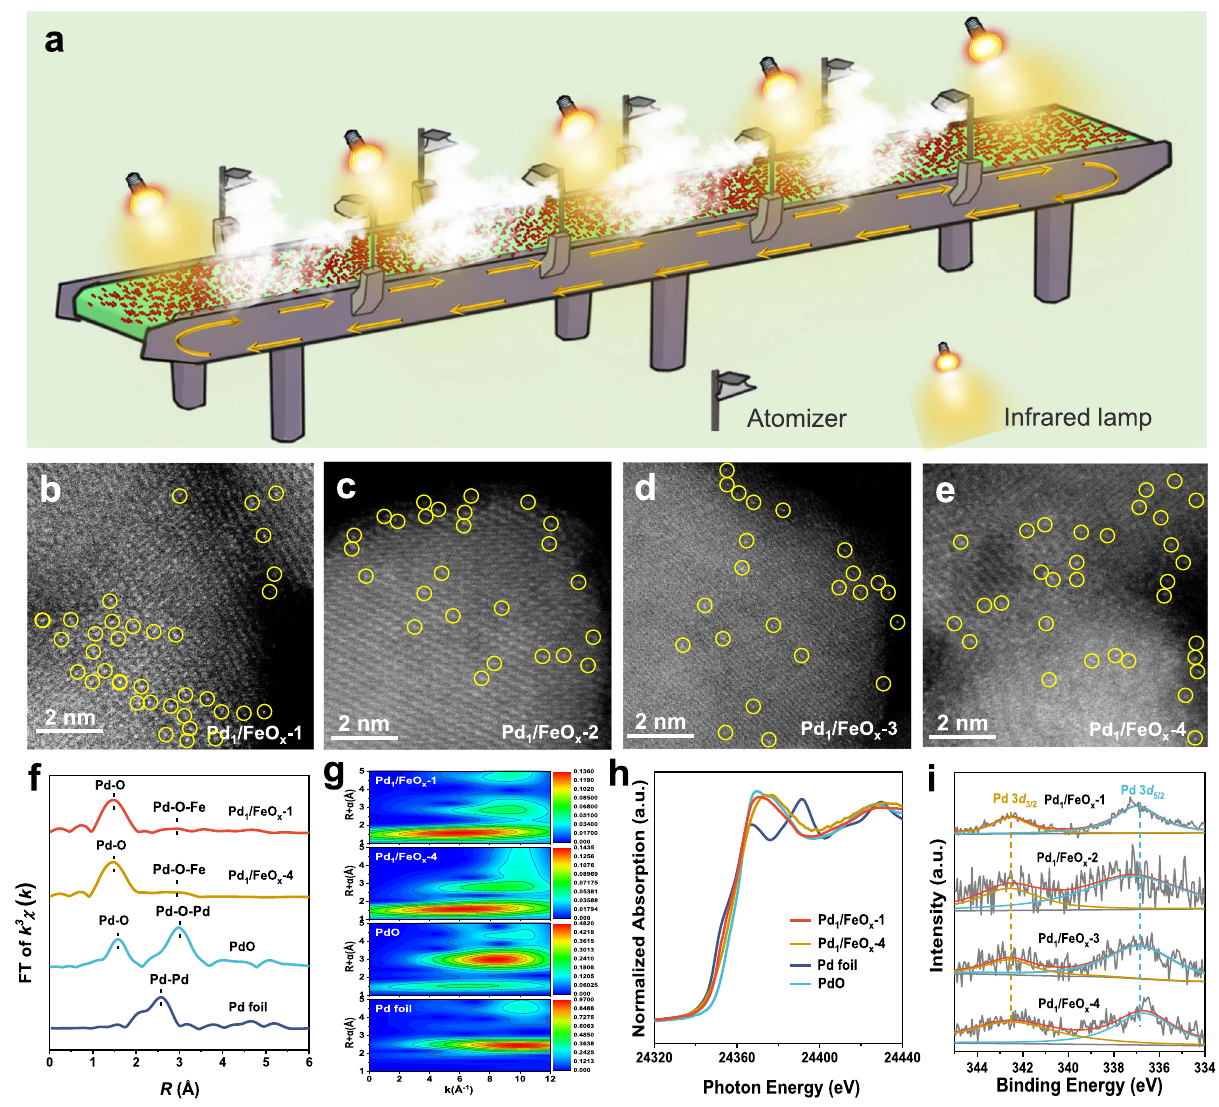
Fig.4|Theproductionlinebasedontheprecursor-atomizationstrategy.a The schemefortheproductionlinethatisbasedontheprecursor-atomizationstrategy. b – e AC HAADF-STEM image of Pd 1 /FeO x -1, 2, 3, 4, respectively. Pd atoms were highlighted by yellow circles. Scale bar, 2nm. f The k 3 -weighted FT spectra of Pd